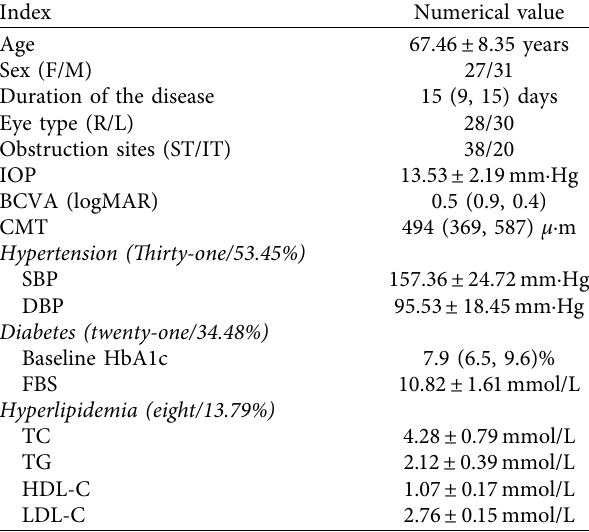
Table 1: Clinical and demographic